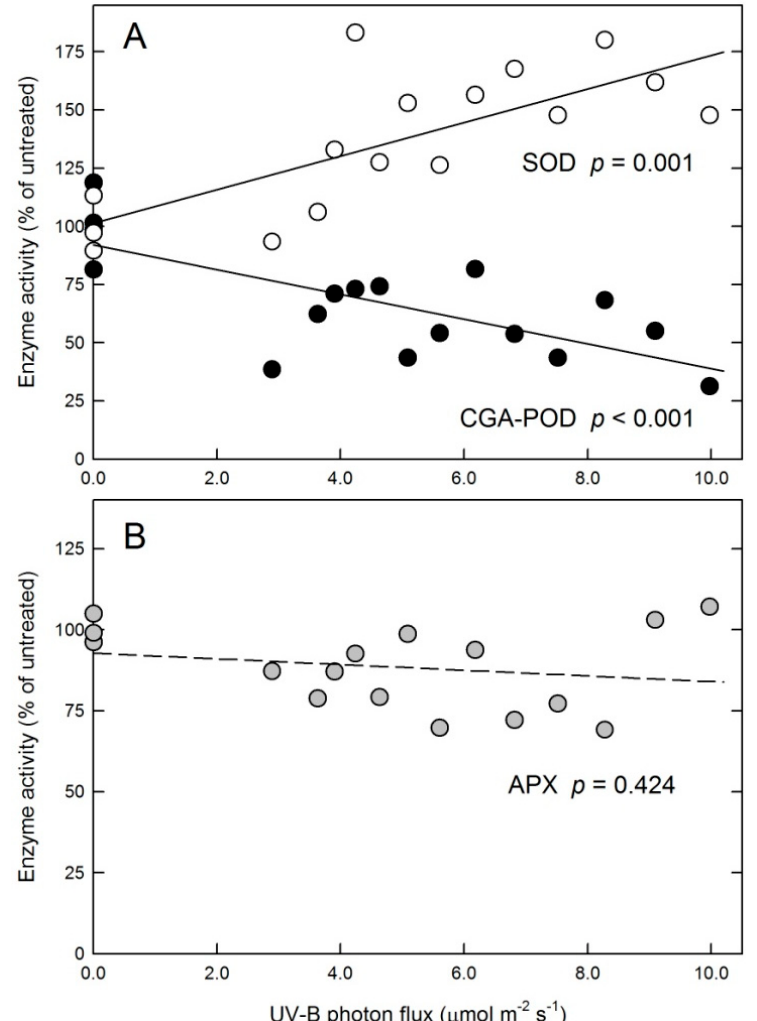
Figure 4. Changes in antioxidant enzyme activities. ( A ) Superoxide dismutase (SOD) and peroxidase enzyme activity assayed with chlorogenic acid (CGA-POD). ( B ) Ascorbate-peroxidase enzyme activity (APX).